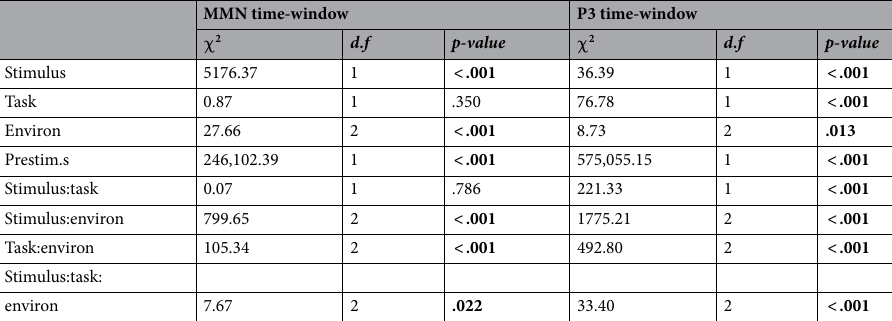
Table 1. Analysis of deviance tables for linear mixed-effects models evaluating voltage changes in the MMN (100–250 ms) and P3 (250–500 ms) time-windows. Note χ 2 = Type II Wald χ 2 test statistic, d.f. = degrees of freedom, stimulus = oddball task stimulus (Deviant, Standard), task = cognitive task condition (Count, Ignore), environ = environmental context (Lab, Field, Campus), prestim.s = prestimulus EEG voltage (scaled). Bold p-values indicate significance at an alpha threshold = .05.